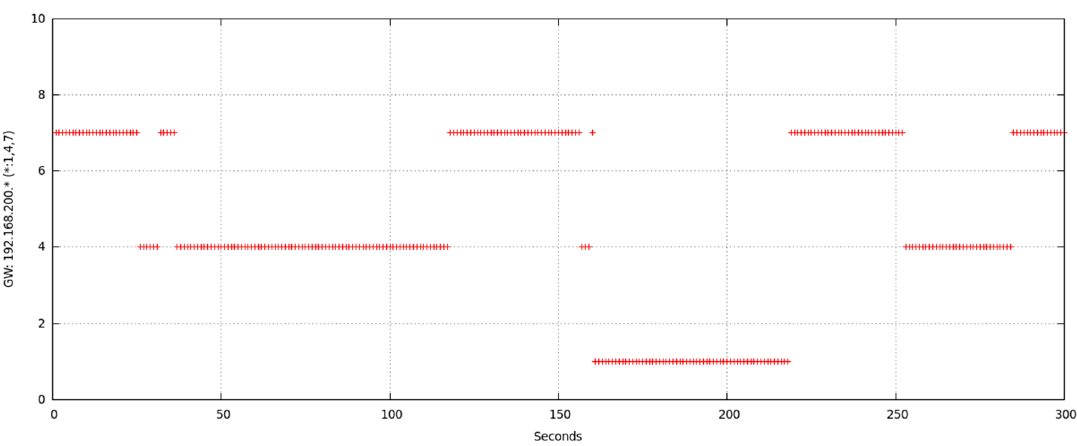
Figure 15. Chosen intermediate node for route from node6 to node1.